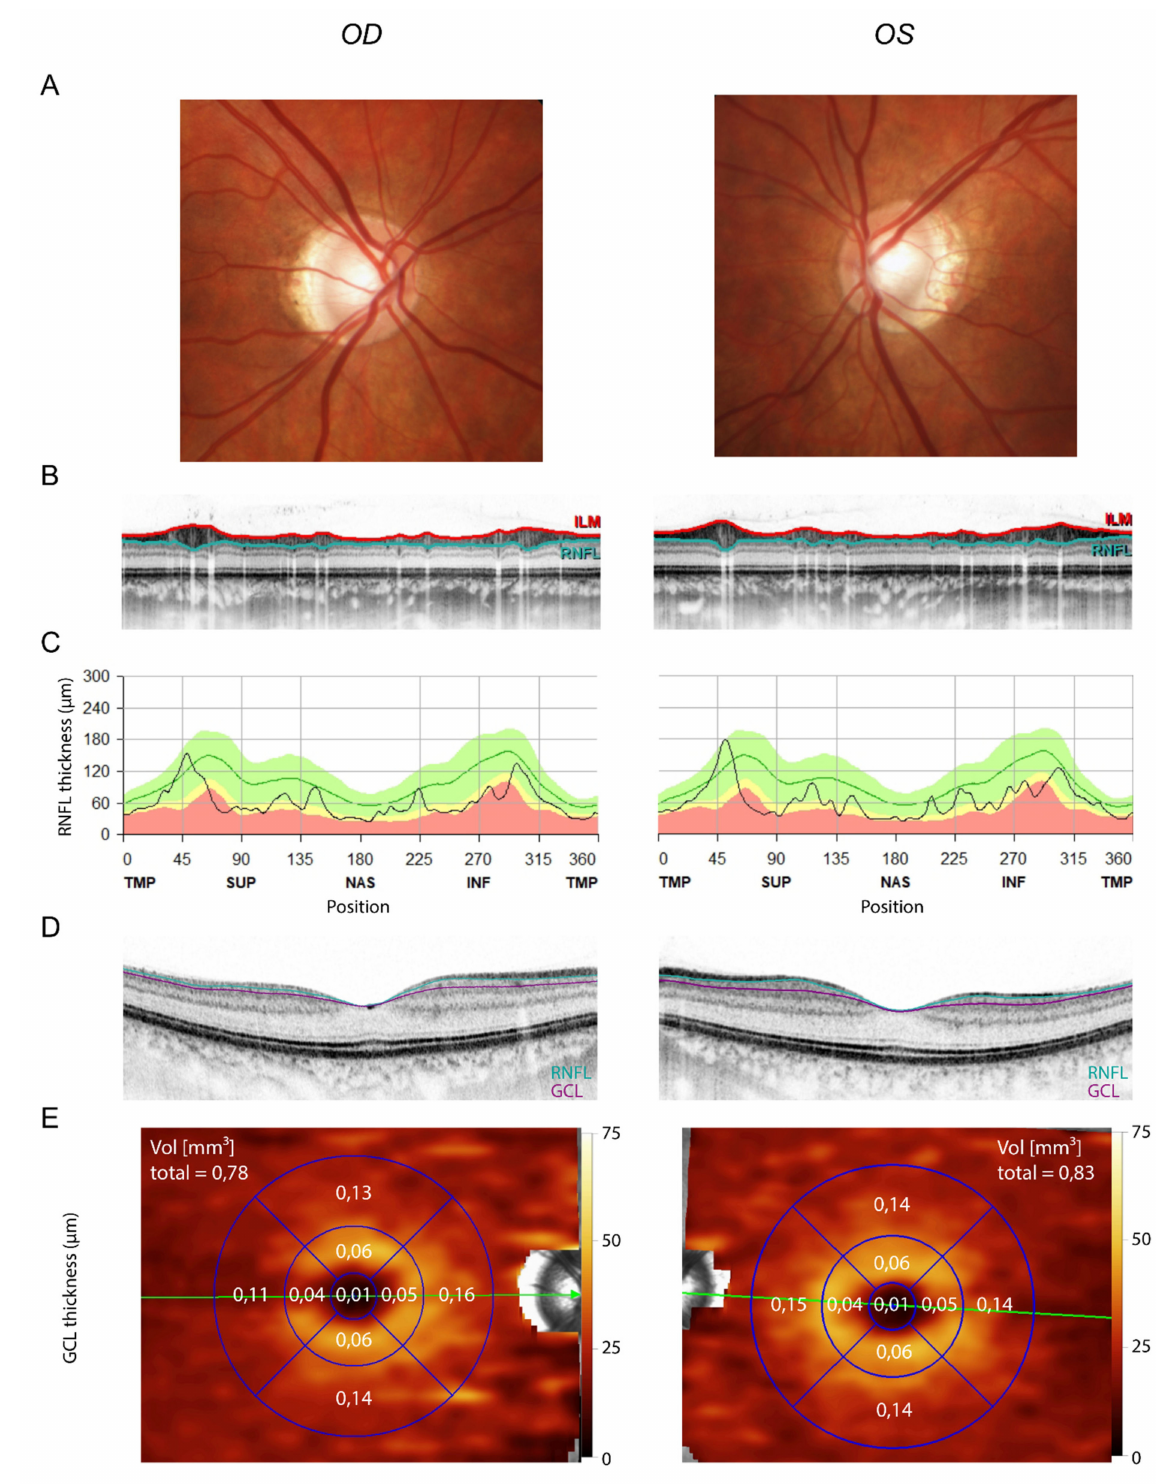
Figure 3. Mild optic atrophy in the mother. ( A ) Fundus images showing mild myopic papillary changes. ( B ) Circumpapillary OCT scan (ILM in red, border between GCL and RNFL in turquoise). ( C ) Macular OCT scan (border between inner nuclear layer and GCL in purple, border between GCL and RNFL in turquoise). ( D , E ) GCL volume quantification from macular OCT. Note the mild reduction in GCL volume (mean in the respective age group = 1.12 mm 3 , 5th percentile = 0.99 mm 3 , 95th percentile = 1.25 mm 3 ; reference data from Meyer et al. (2021)